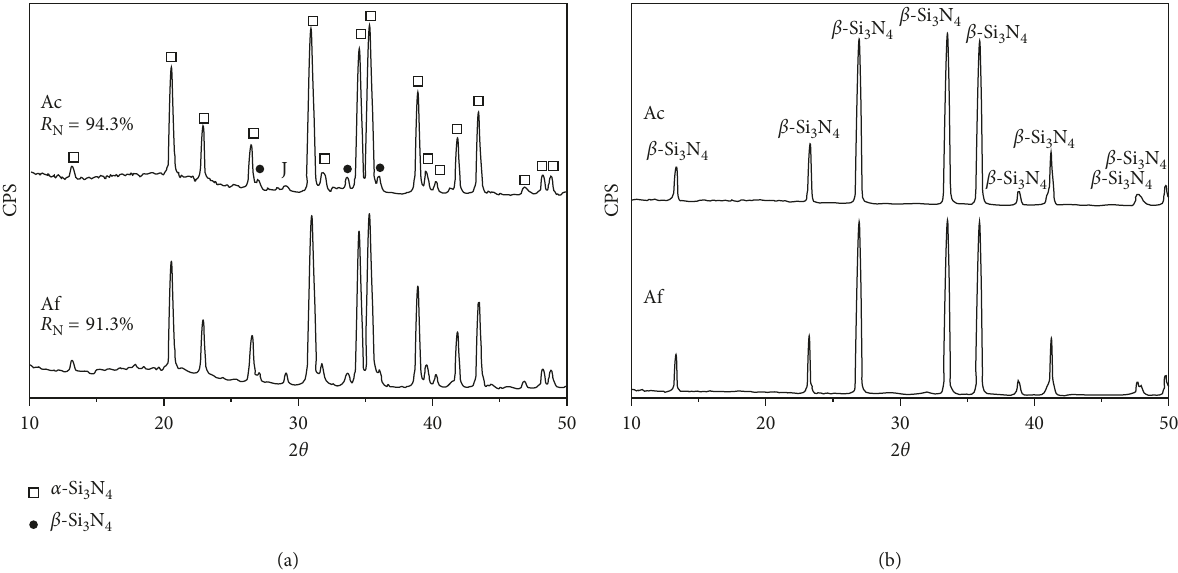
Figure 2: XRD patterns and phase analysis for the RBSN (a) and SRBSN (b) specimens. The values ( R degree for RBSN specimens after the nitriding process.